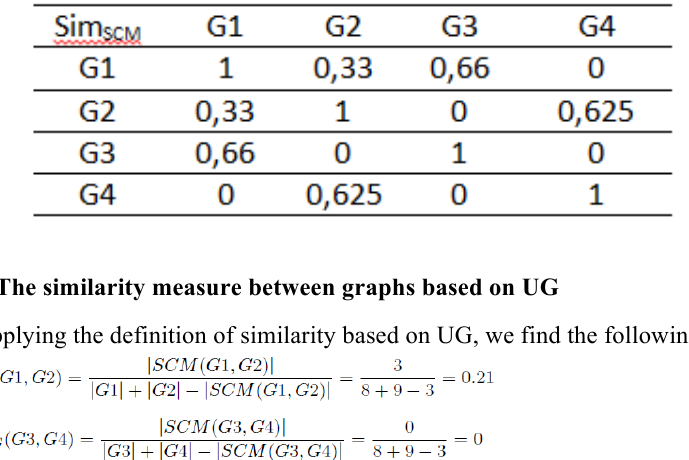
Table 4. Similarity, Sim CMS , between